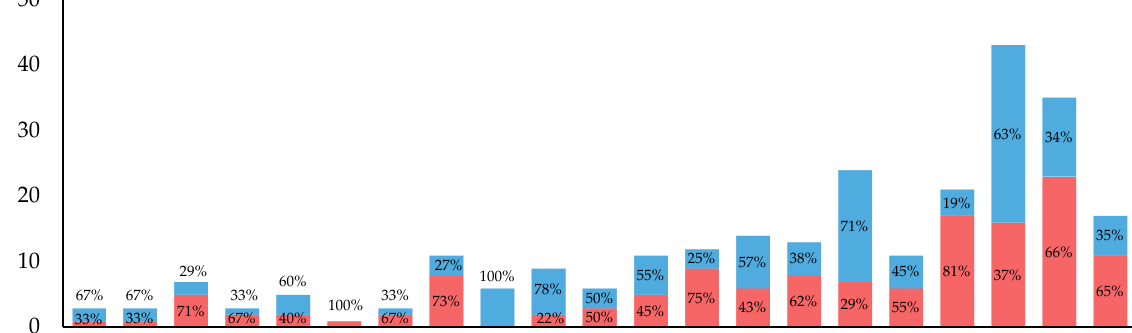
Figure 3. Trends in the number of new biomarker–drug pairs approved per year with annual proportions by cancer vs. non-cancer from 2000 to 2020. Data shown through July of 2020.